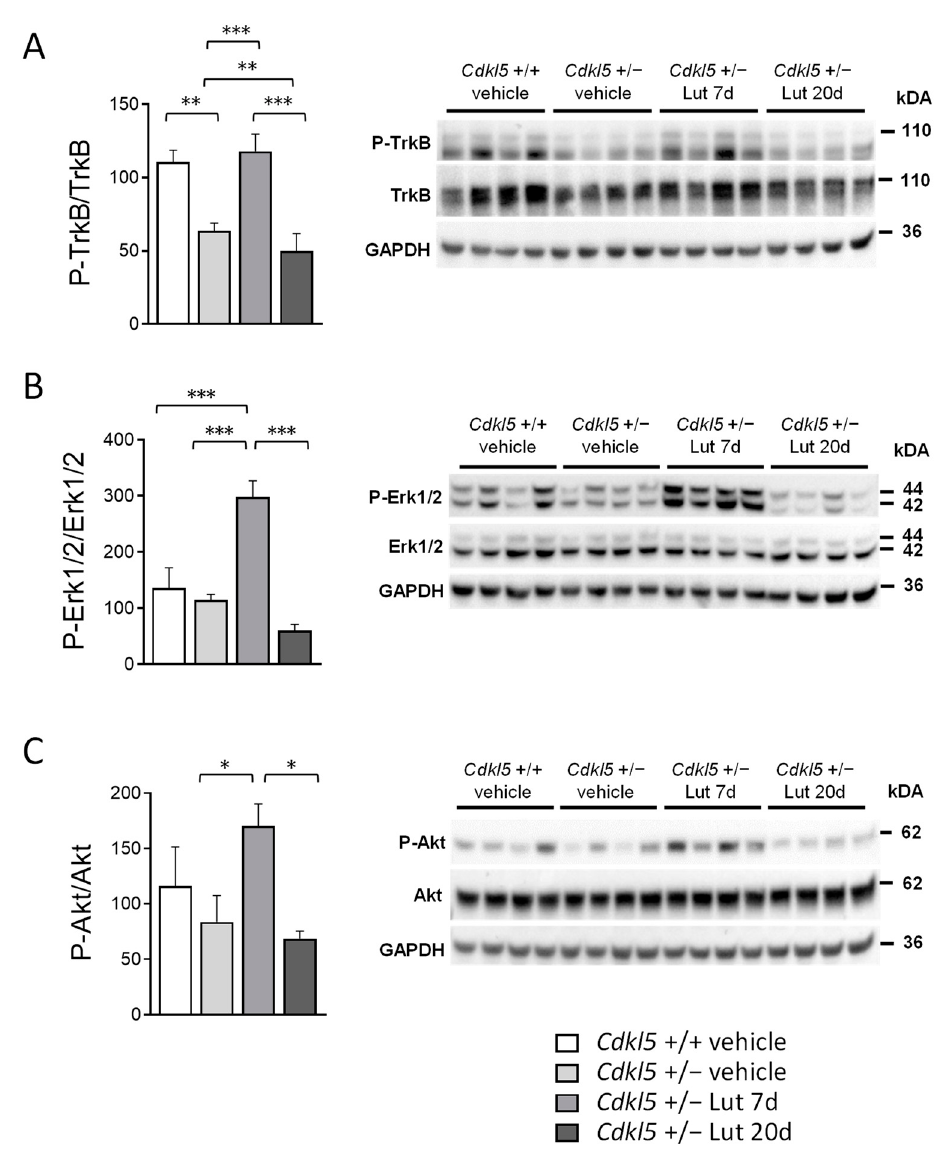
Figure 7. Effect of luteolin treatment on BDNF/TrkB signaling pathway activation in the cortex of Cdkl 5 +/ − mice. ( A ) Western blot analysis of P-TrkB levels in somatosensory cortex homogenates from vehicle-treated Cdkl 5 +/+ (n = 4) and Cdkl 5 +/ − (n = 4) mice, 7-day luteolin treated Cdkl 5 +/ − (Lut 7d, n = 4) and 20-day luteolin treated Cdkl 5 +/ − (Lut 20d, n = 4) mice. The histogram on the left shows P-TrkB protein levels normalized to corresponding total TrkB protein levels. Examples of immunoblot for P-TrkB on the right. ( B ) Histogram on the left shows protein levels of phosphorylated Erk1/2 normalized to the respective total form in cortex homogenates from mice treated as in ( A ). Examples of immunoblot for P-Erk1/2 on the right. ( C ) Histogram on the left shows protein levels of phosphorylated Akt normalized to the respective total form in cortex homogenates from mice treated as in ( A ). Examples of immunoblot for P-Akt on the right. Data are expressed as a percentage of vehicle-treated Cdkl 5 +/+ mice. Values represent mean ± SEM. * p < 0.05, ** p < 0.01, *** p < 0.001. Fisher’s LSD test after two-way